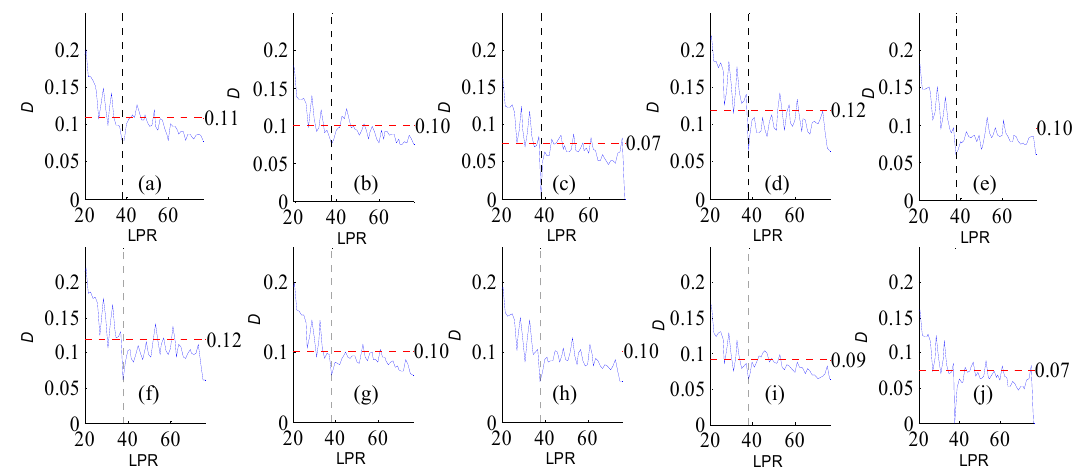
Figure A26. Variation of flow regime alteration degree (D) measured by the RVA with change in the length of post-impact flow time series (LPR) under a periodicity of 37 years. ( a ), ( b ), ( c ), ( d ), ( e ), ( f ), ( g ), ( h ), ( i ), and ( j ) correspond to pre-impact flow time series length = 26, 32, 37, 42, 48, 53, 58, 63, 69, and 74 years, respectively. The abscissa value for the vertical dotted line is 37. The ordinate value for the horizontal dotted line is the mean degree of flow regime alteration in each subfigure.